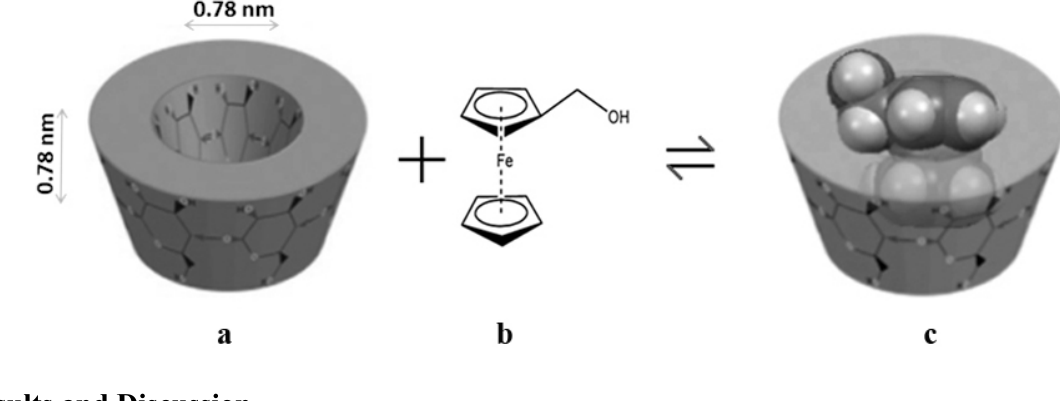
Figure 1. ( a ) Approximate dimensions of β -CD ( b ) molecular structure of FeMeOH and ( c ) schematic representation of FeMeOH: β